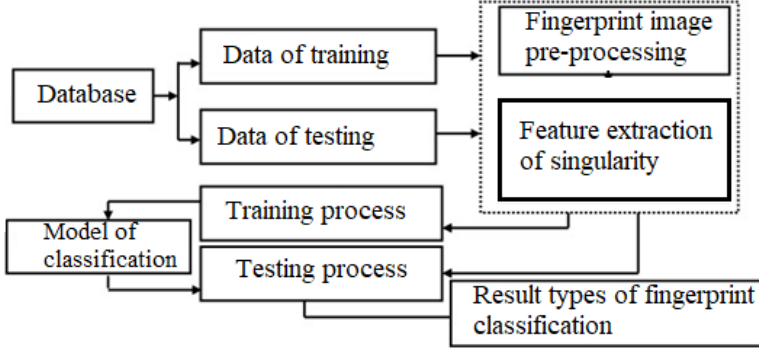
Figure 6. Block diagram of fingerprint classification using method proposed.